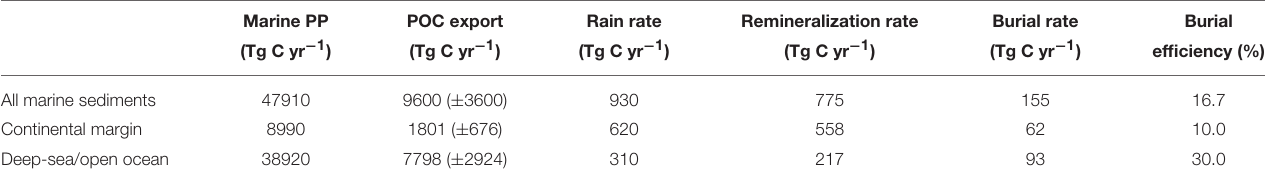
TABLE 4 | Sediment organic carbon budgets in the oceans (Tg C yr − 1